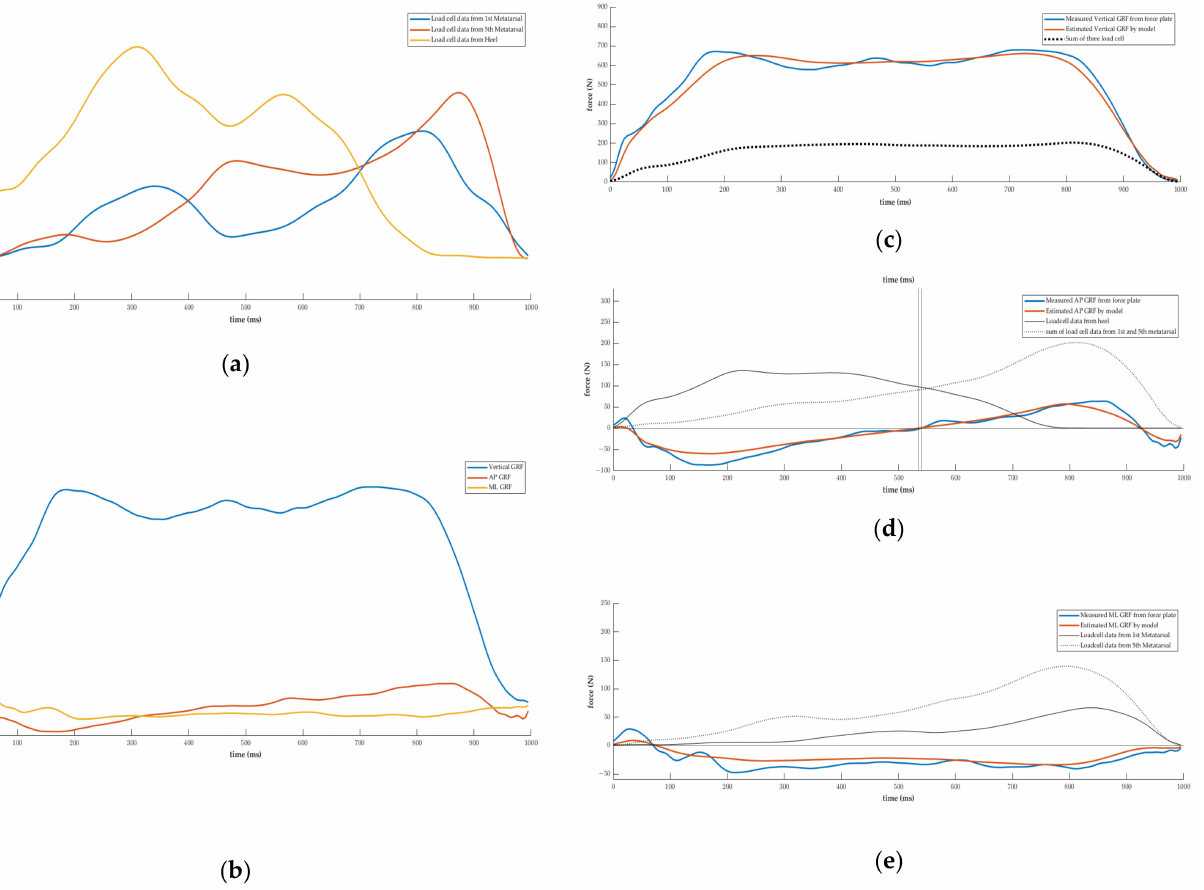
Figure 4. Example signals. ( a ) Measured signals from load cells, i.e., input signals for model. ( b ) Measured GRF from force plate, i.e., output signals for model. ( c ) Vertical GRF measured from force plate and estimated by model. ( d ) AP GRF measured from force plate and estimated by model. ( e ) ML GRF measured from force plate and estimated by